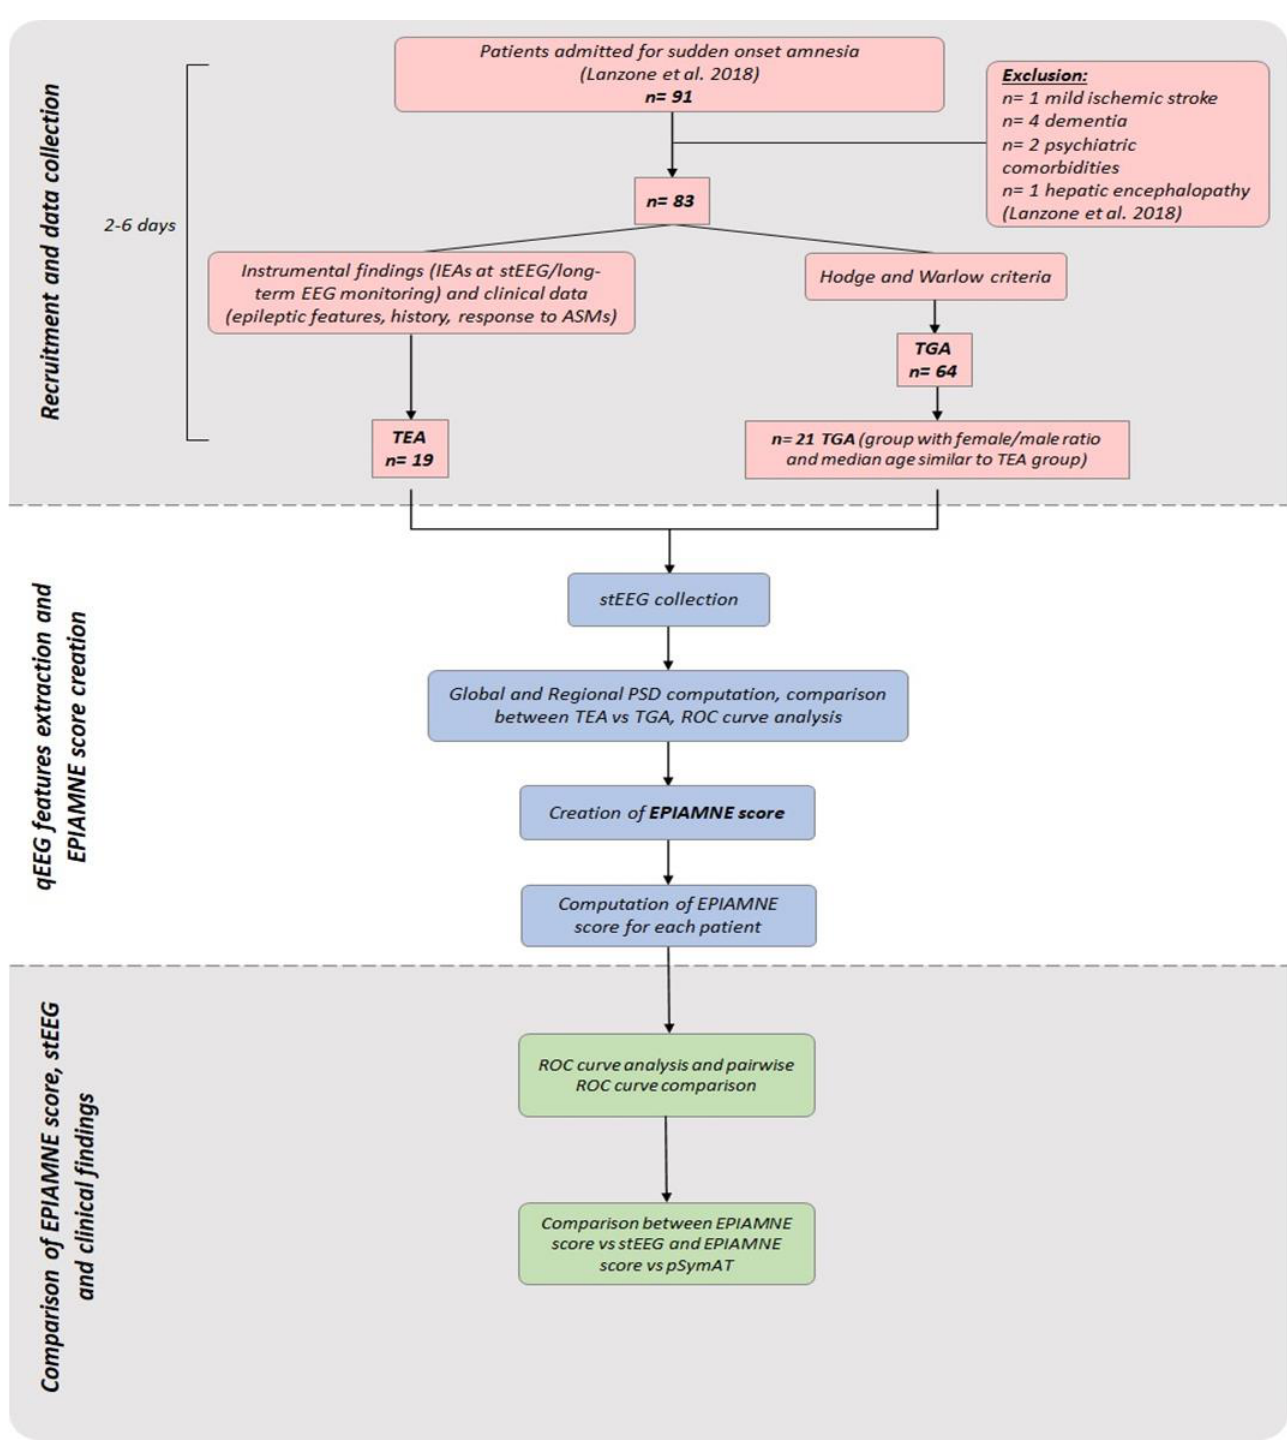
Figure 1. Flow chart of the study. ASMs (antiseizure medications), EPIAMNE score (EPIlepsy AMNEsia Score), IEAs (intercritic EEG anomalies), pSymAT (presence of symptoms atypical for TGA), stEEG (standard EEG), TEA (transient epileptic amnesia), TGA (transient global amnesia)